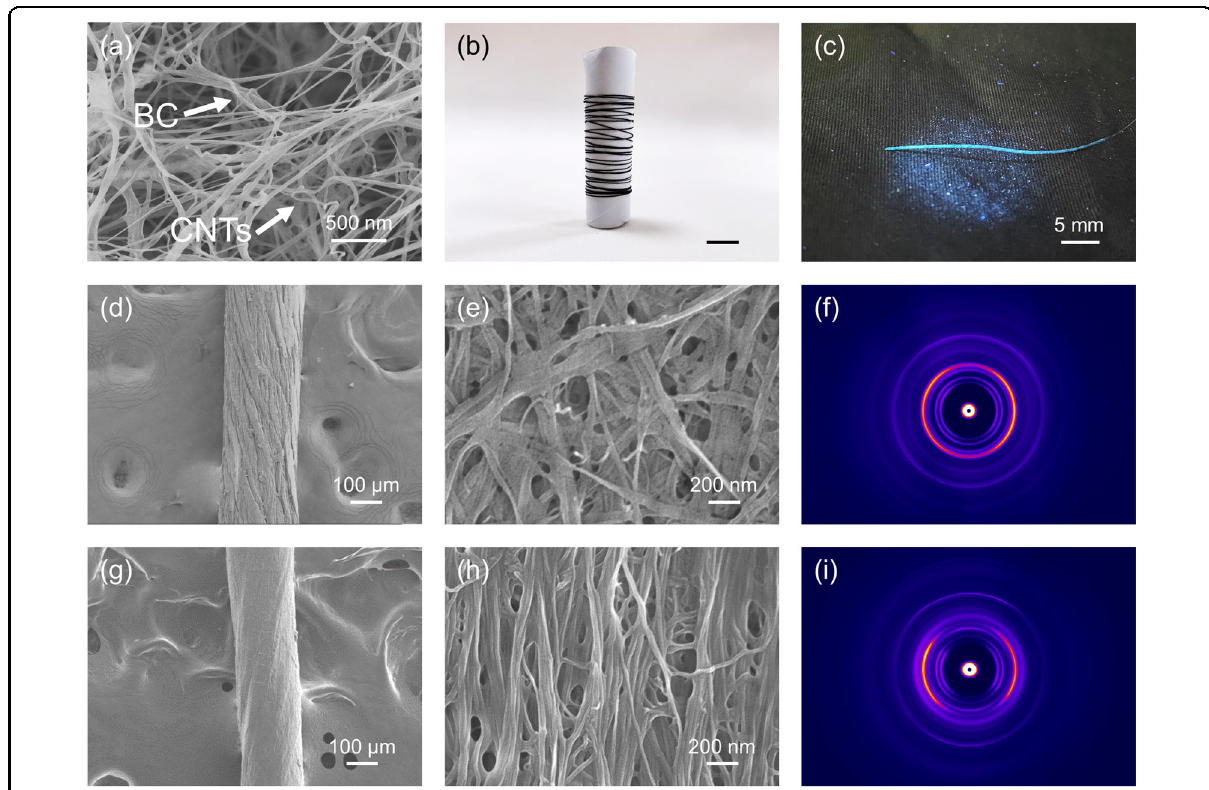
Fig. 2 Characterization of the composite fi bers (15.9 wt% CNT). a Scanning electron microscopy (SEM) image of the composite hydrogel, showing the uniform distribution of CNTs in the BC network. b A roll of the muscle-inspired fi ber. The scale bar corresponds to 1 cm. c The fl uorescence of muscle-inspired fi bers is excited under ultraviolet light. d SEM image of the composite fi bers with only wet twisting (BC/CNT fi bers), showing a rough surface. e SEM image of the BC/CNT fi bers, showing randomly oriented CNTs and BC nano fi bers. f Two-dimensional wide-angle X-ray diffraction (2D-WAXD) patterns of BC/CNT fi bers. g SEM image of the composite fi bers with wet drawing and wet twisting (WD-BC/CNT fi bers), showing a smooth surface. h SEM image of WD-BC/CNT fi bers, showing a highly aligned structure. i The 2D-WAXD pattern of WD-BC/CNT fi